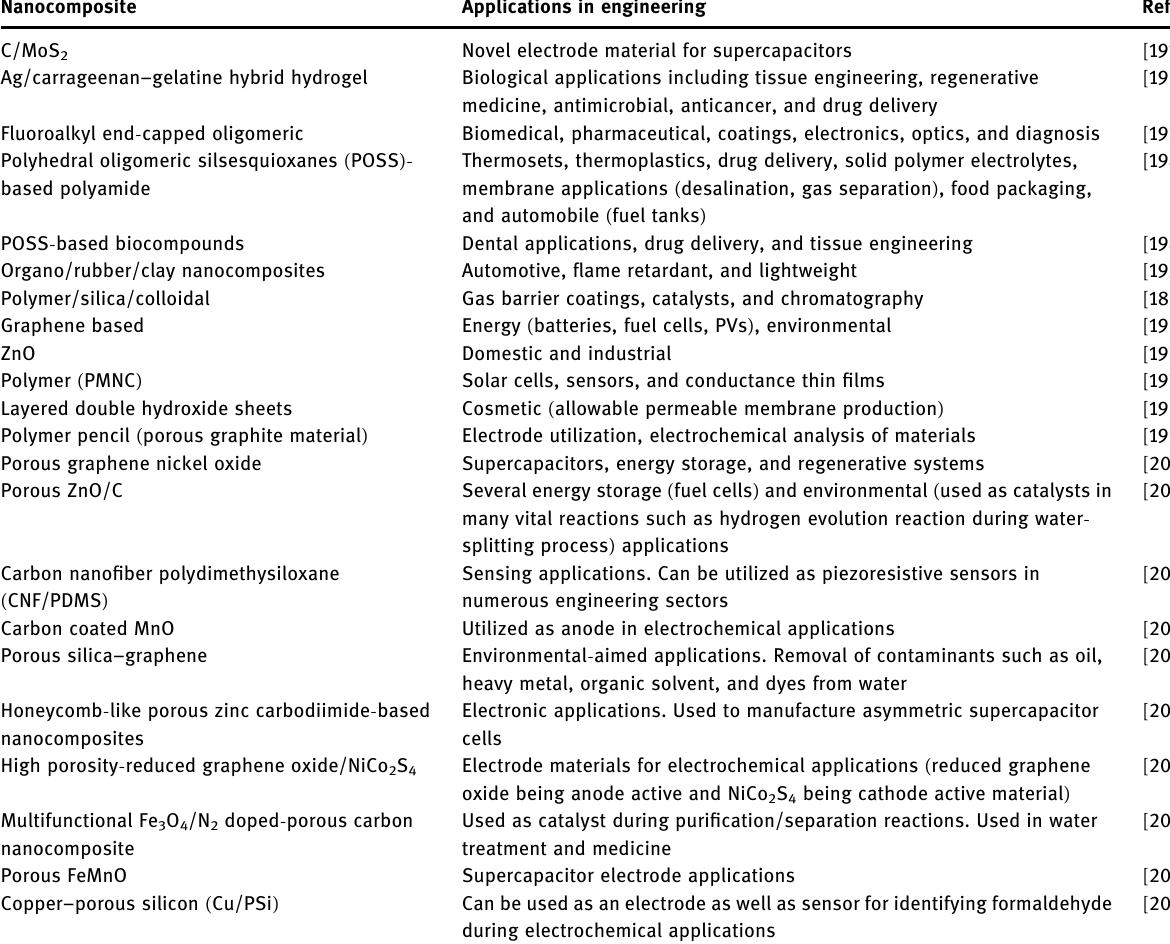
Table 20: Various nanocomposites and their respective usage in the engineering sector